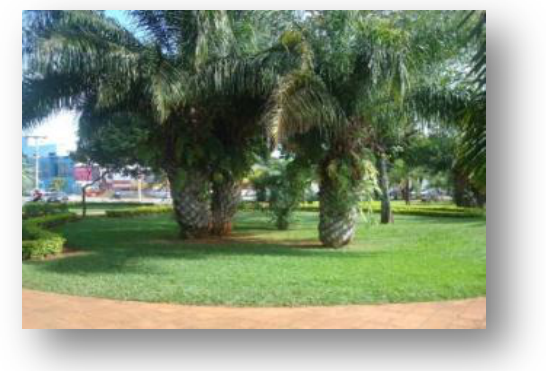
Figure 17. Spatial Query: what are the districts with vegetation Figure 14 – Vegetation area pointed out as “Small change” in change less than 0.2 and income higher than R$ 3.500,00. the vegetation change map. The Central Sector and the Campinas Sector appeared as districts with better income and low change, which are also confirmed, as illustrated in Figure 18.